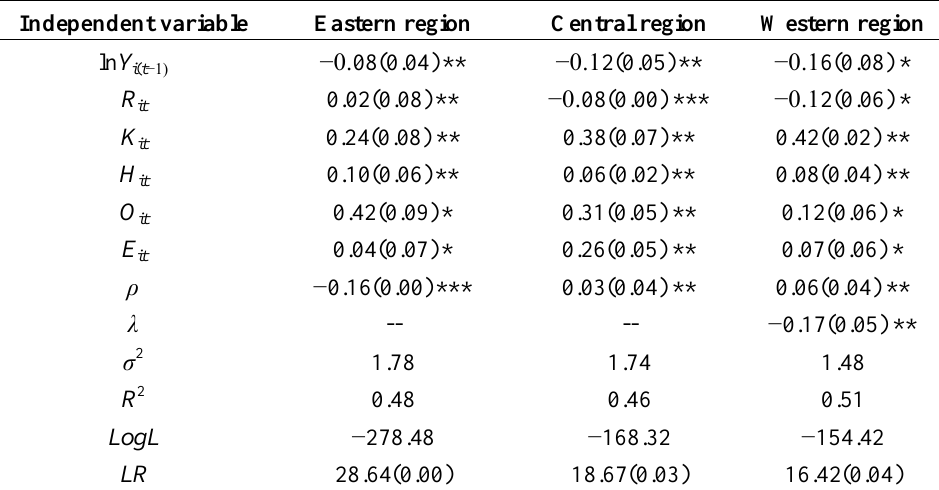
Table 4. Results of spatial panel